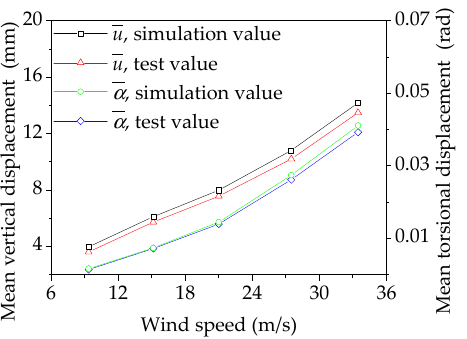
Figure 9. Mean displacement response comparison between the sectional model vibration tests and the calculation results of the finite element simulation.